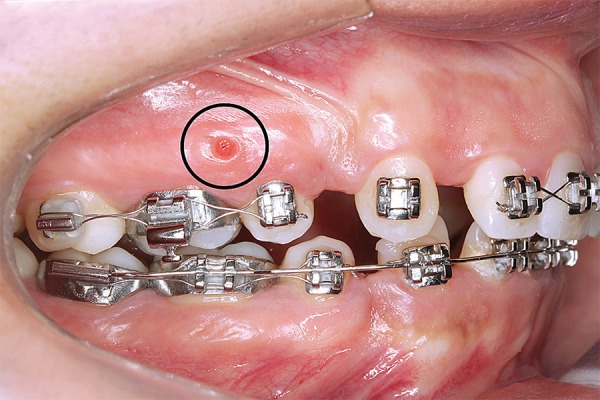
Mini-implant loss.